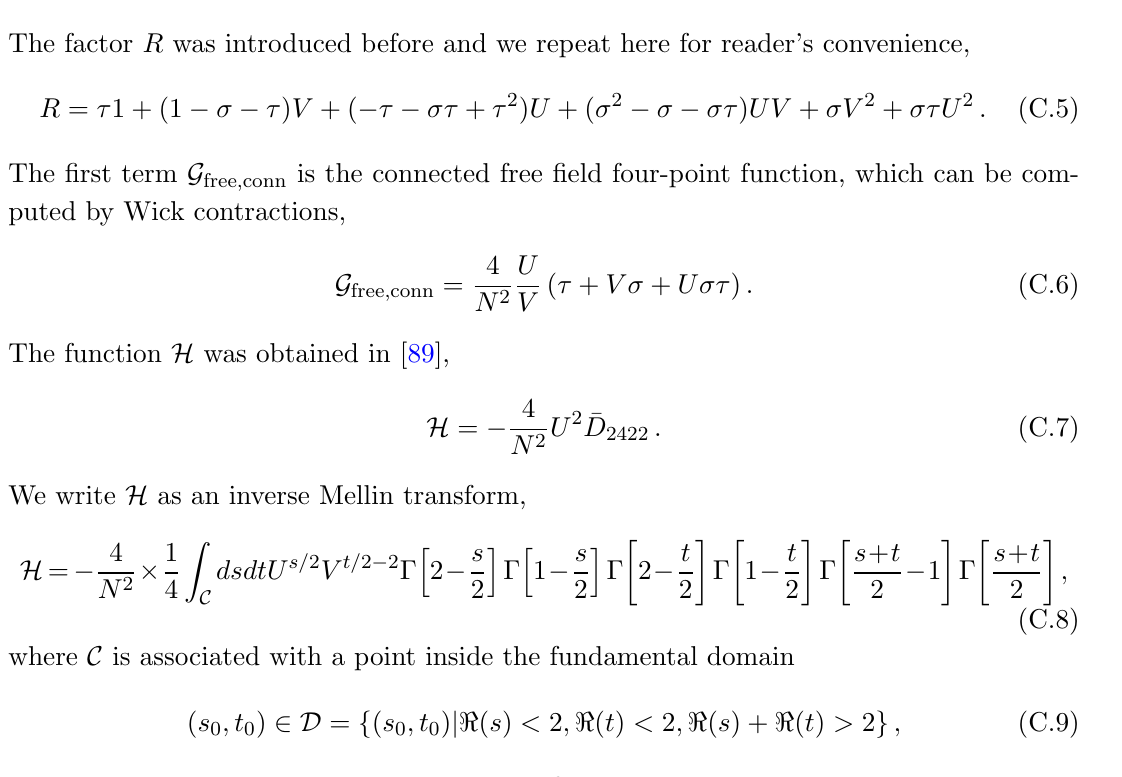
Figure 7 . The fundamental domains for the \unmassaged" supergravity